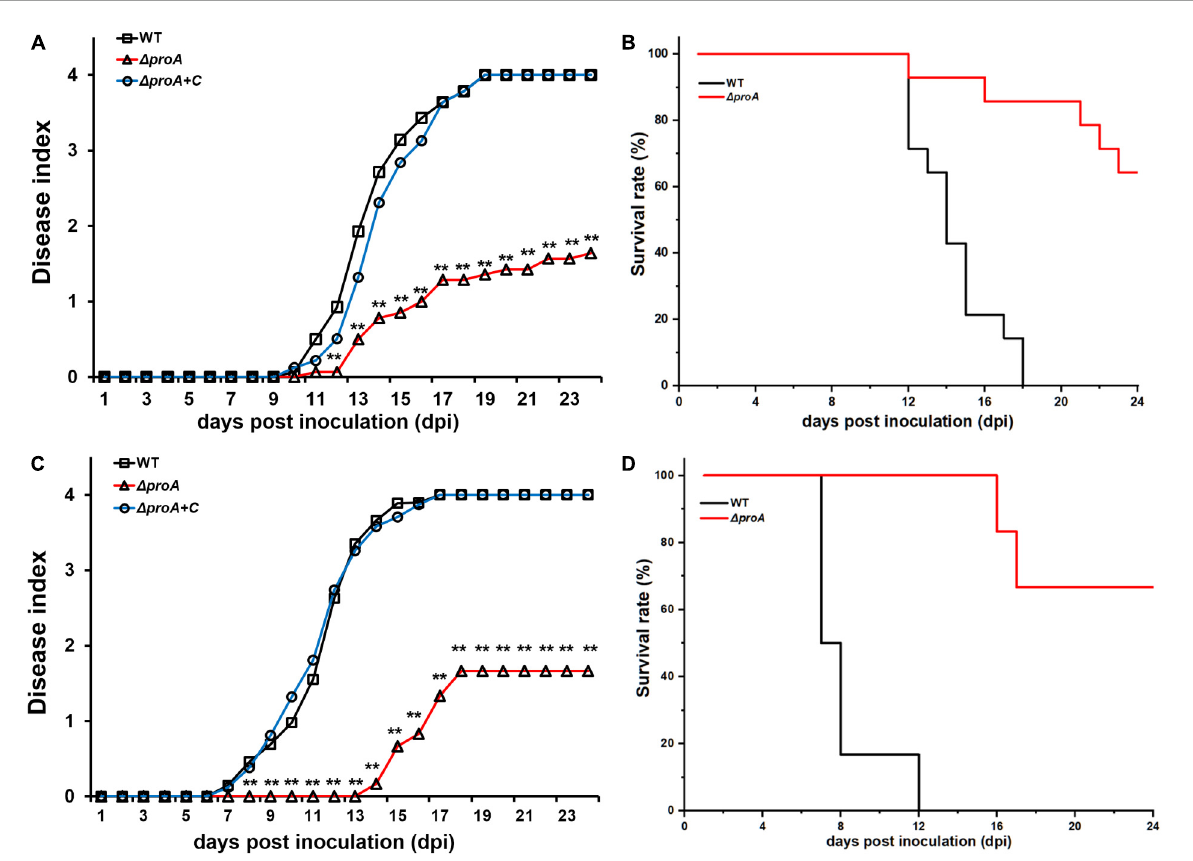
FIGURE4 Virulence test of proA mutants in tobacco plants with the inoculation method of (A,B) leaf infiltration, which enables direct invasion into intercellular spaces of leaves, and (C,D) soil-soaking inoculation, which mimics natural invasion through roots. WT, the wild-type strain, RK5050 (OE1-1, popA-lacZYA ); (cid:49) proA , RQ5735 (RK5050, (cid:49) proA ). (cid:49) proA + C, RQC1485 (complementary proA in RQ5735). For the leaf infiltration, about 50 µ l of the bacterial suspension of 10 8 cfu ml − 1 was infiltrated into the tobacco leaves with a blunt-end syringe. For the soil-soaking inoculation, a bacterial suspension was poured into a pot at a final cell density of 10 7 cfu g − 1 of soil. Panels (A,C) refer to the virulence test with the disease index. Wilt symptoms were inspected daily and scored on a disease index scale from 0 to 4 (0, no wilting; 1, 1–25% wilting;